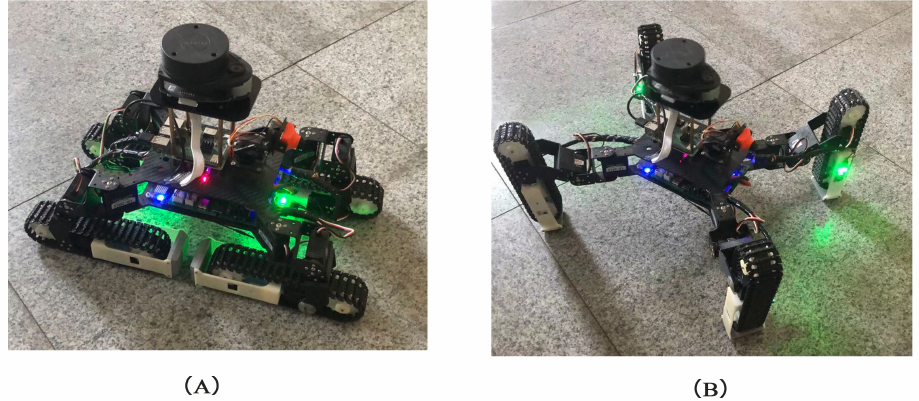
Figure 1. ( A ) The tracked mode of TALBOT. ( B ) The legged mode of